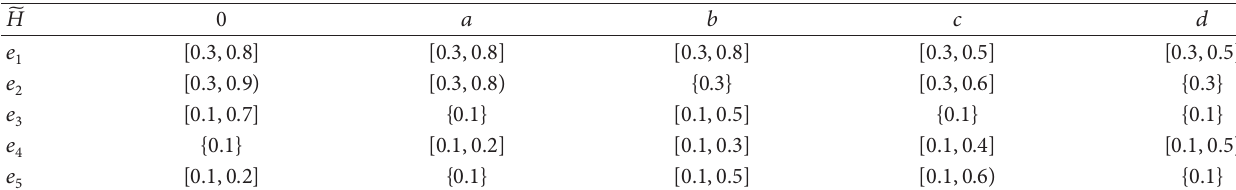
Table 4: Tabular representation of the hesitant fuzzy soft set